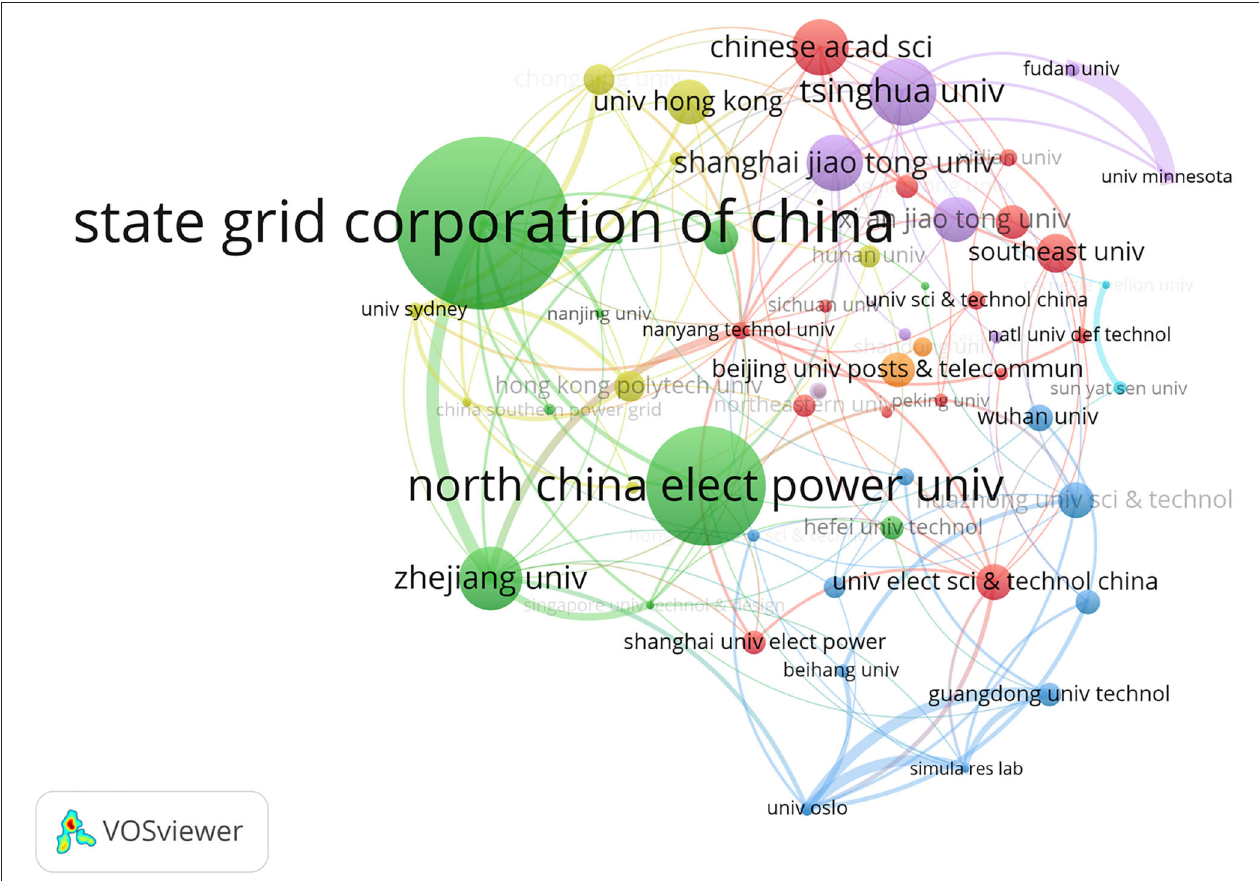
FIGURE 6 | Institution co-authorship network in China in the field of SG. VOSviewer parameters: counting method: full counting, minimum occurrences 10, a total of 61 institutions, normalization using LinLog/modularity method, layout parameters: attraction = 8, repulsion =